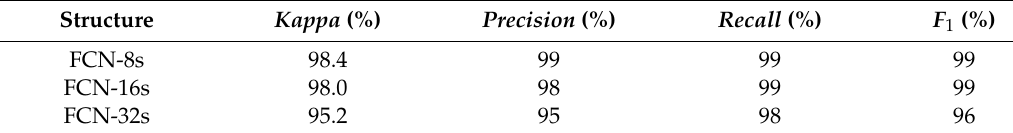
Table 2. Precision comparison of FCN-8s, FCN-16s, and FCN-32s.